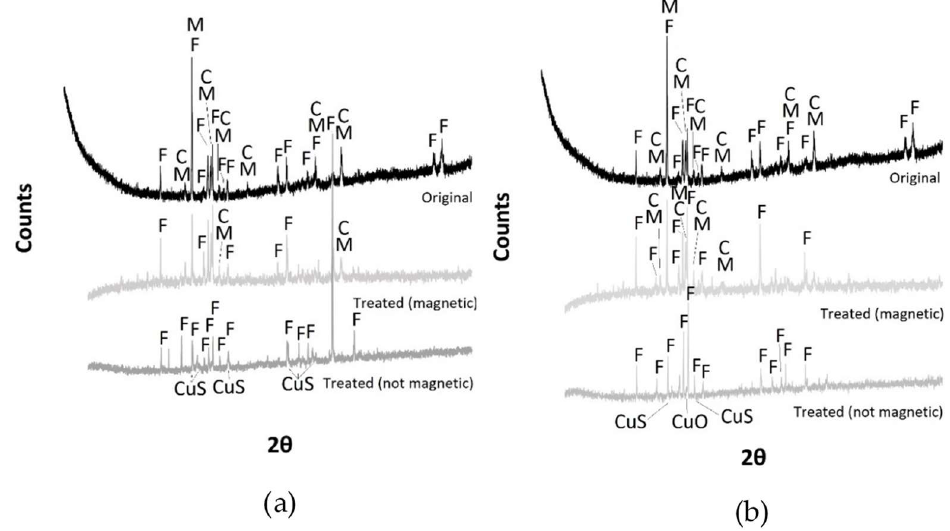
Figure 11. ( a ) Specimen CuSin2 (C, CuFe 2 O 4 ; F, Fe 2 SiO 4 ; M, Fe 3 O 4 and all the iron spinel; CuS, Cu 2 S, Cu 0 . 98 S). ( b ) Specimen CuSin3 (C, CuFe 2 O 4 ; F, Fe 2 SiO 4 ; M, Fe 3 O 4 and all the iron spinel; CuS, Cu 2 S, Cu 0 . 98 S; CuO).